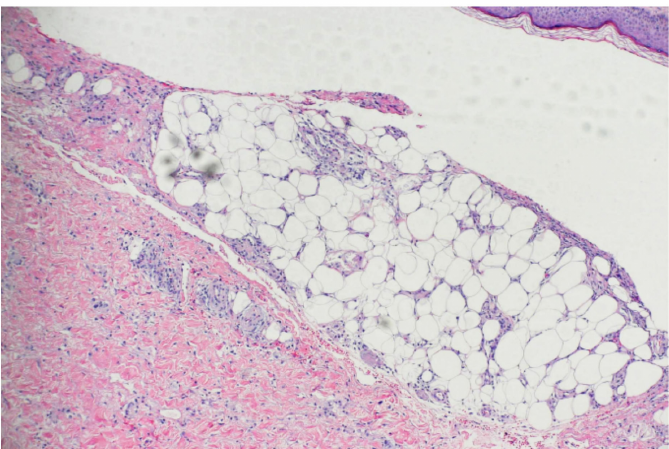
Figure 2. A representative pathological finding of erythema